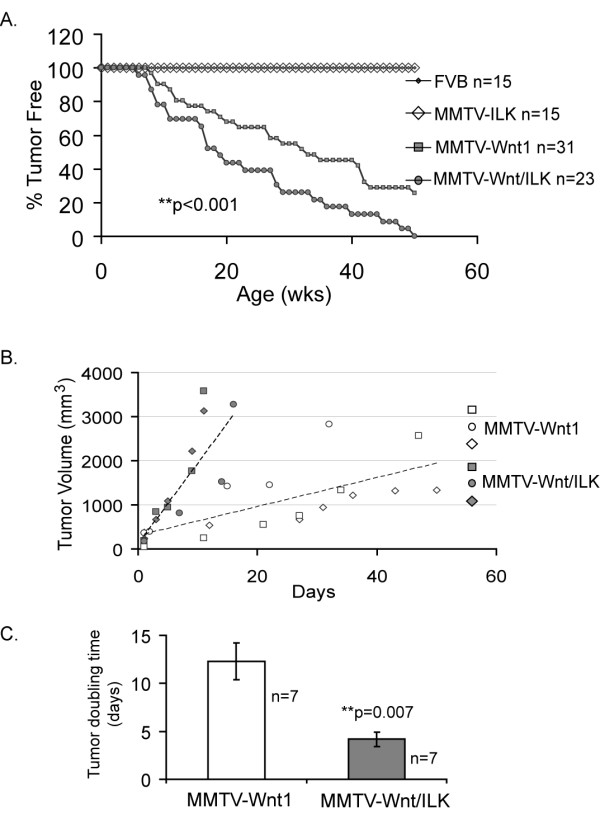
Mammary tumor formation and tumor growth in MMTV-Wnt/ILK mice. (a) Kaplan-Meier analysis of the percentage of tumor-free mice over time; P < 0.001. (b) Linear representation of growth rate from three randomly selected tumors from each transgenic group shows an accelerated rate of growth in MMTV-Wnt/ILK mice. (c) Tumor-doubling time was calculated based on the exponential curve fit of the tumor-volume measurements against time. The results show the mean doubling time for n = 7 tumors collected in each group, which supports the proliferative advantage of the tumors arising in the MMTV-Wnt/ILK transgenic group. The error bars represent the standard error of the mean (SEM), and the **P value was calculated by using a paired two-sample t test with a 95% confidence interval.